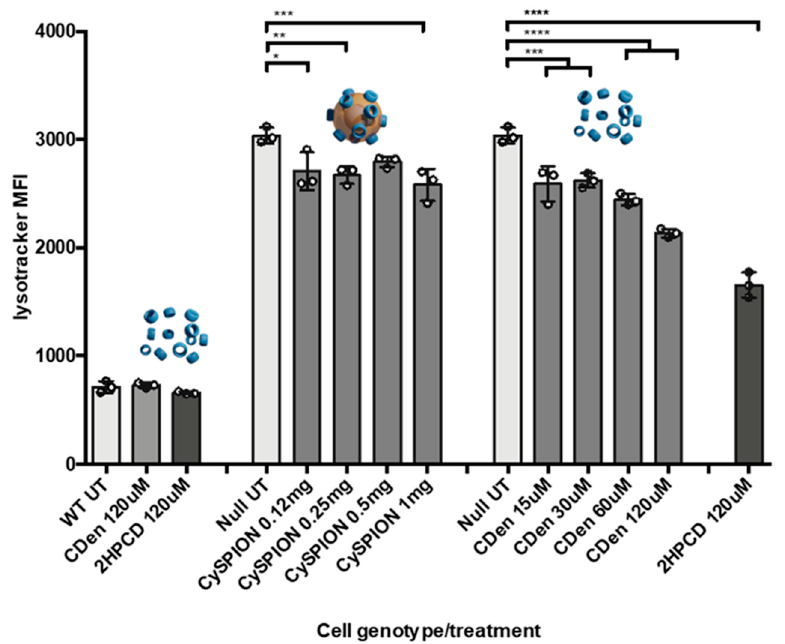
Figure 2. Lysotracker TM staining of CDen treated CHO cells. LysoTracker TM staining of WT and Npc1-deficient CHO cells treated with the indicated doses of CySPION, CDen and 2HPCD for 72 h. 1 mg CySPION dose is equivalent to 120 µ M CDen. Data are mean ± SD, N = 3 replicates per sample. Statistical analysis, one-way ANOVA, **** p < 0.0001, *** p < 0.001, ** p < 0.01, * p < 0.05. Data are representative of two independent experiments.